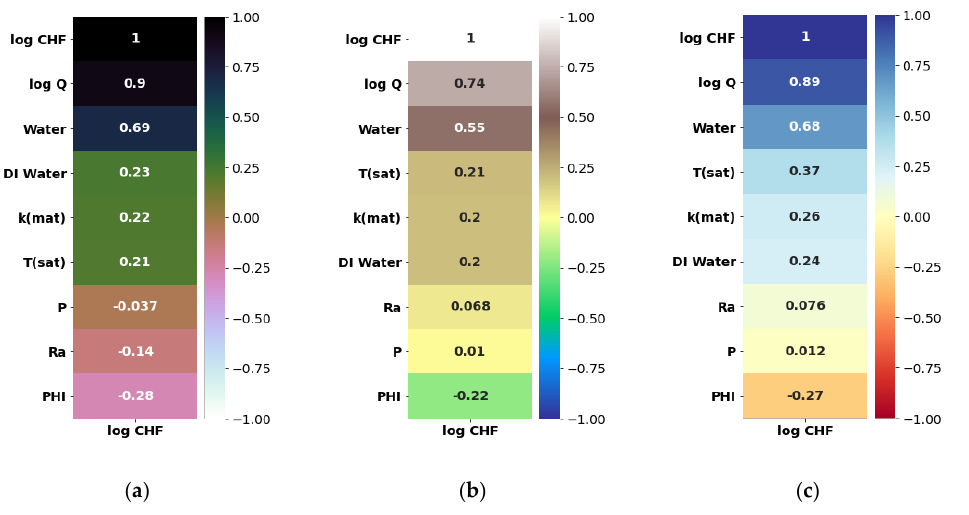
Figure 4. Correlating all CHF data with categorical variables: ( a ) Pearson correlation, ( b ) Kendal correlation, and ( c ) Spearman correlation.